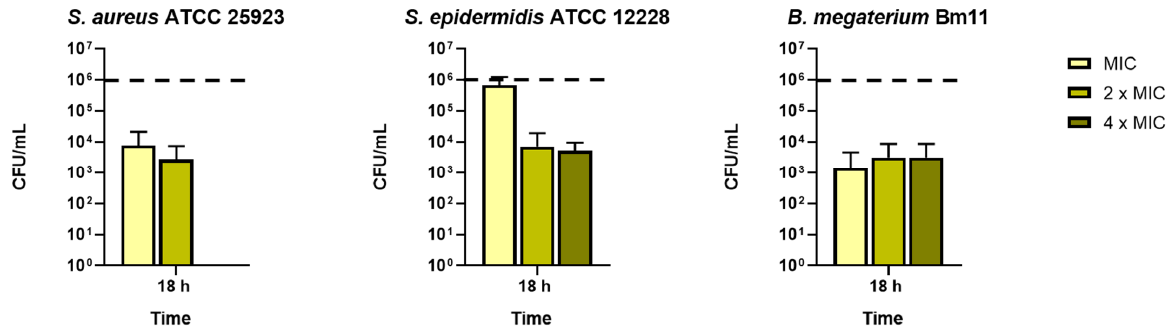
Figure 1. Bactericidal activity of compound 7 at its MIC, 2 × MIC, and 4 × MIC evaluated after 18 h of treatment by CFU counting. The values are the mean ± the standard error of the mean (SEM) obtained from at least three independent experiments. The dotted line indicates the initial number of bacterial cells (1 × 10 6 CFU/mL).